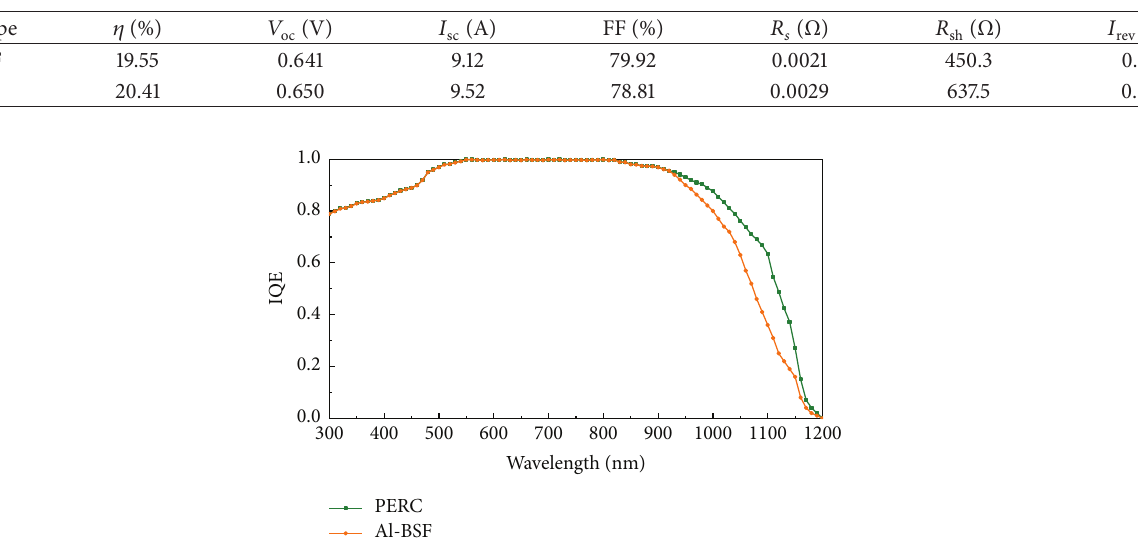
Figure 2: The experimental sample of Mc-Si solar cells with PERC structure. Table 3: Cz-Si solar cells parameters with Al-BSF and PERC structure.